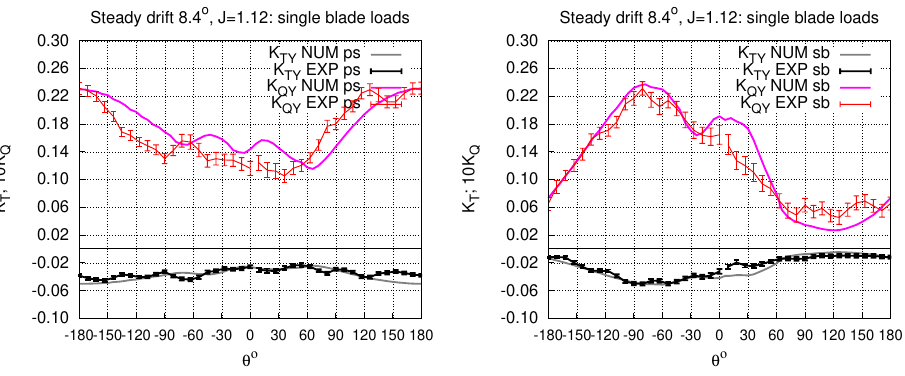
Figure 13. Propulsive performances of the model hull in ahead motion at 8.4 ◦ drift angle, J = 1.12: single blade contribution to tangential force coefficient and moment. ( Left ) portside propeller. ( Right ) starboard propeller.